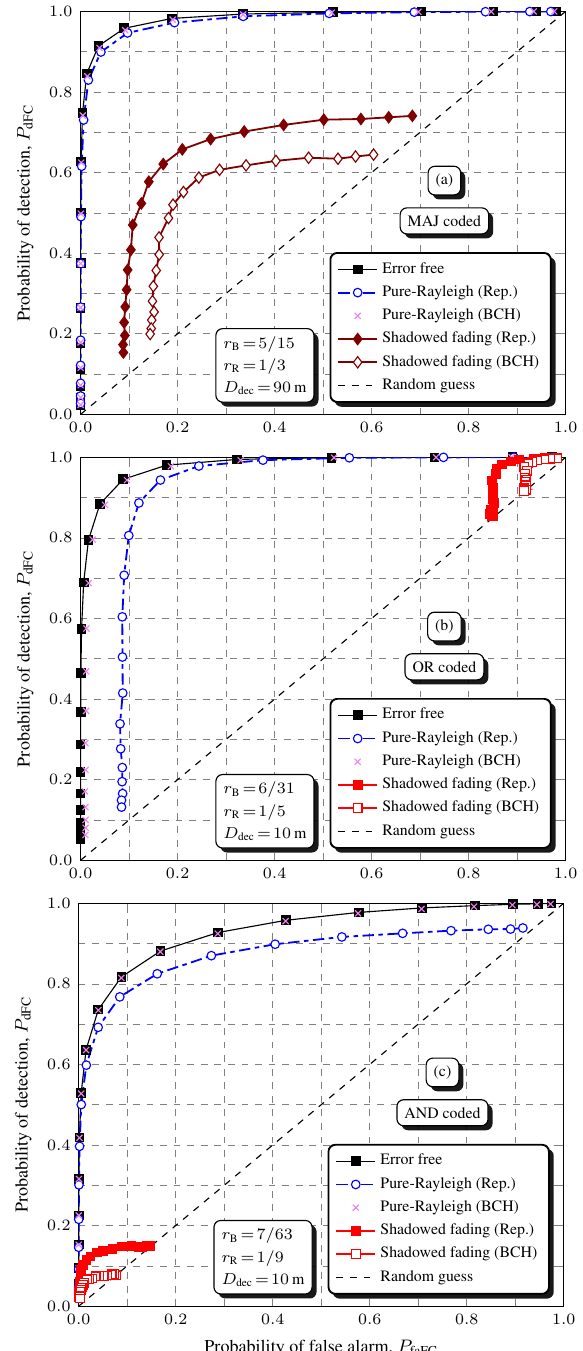
Figure 5. ROCs considering coded report channel transmissions via BCH and Repetition codes, for E b / N 0 = 6 dB, σ dB = 12.28 dB, and L = 50 m: MAJ rule ( a ), OR rule ( b ), and AND rule ( c ). This figure is better viewed in